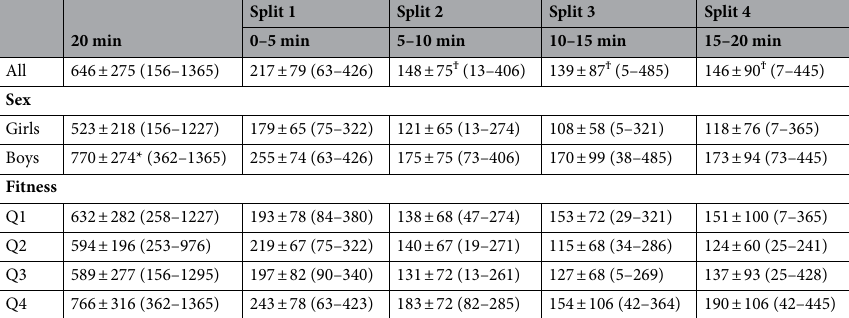
Table 4. Mean ± SD (range) speed zone entries made by participants during The Daily Mile. Q Quartile. Ϯ Denotes a significant difference ( p ≤ 0.05) from Split 1. *Indicates number of speed zone entries by boys significantly greater than